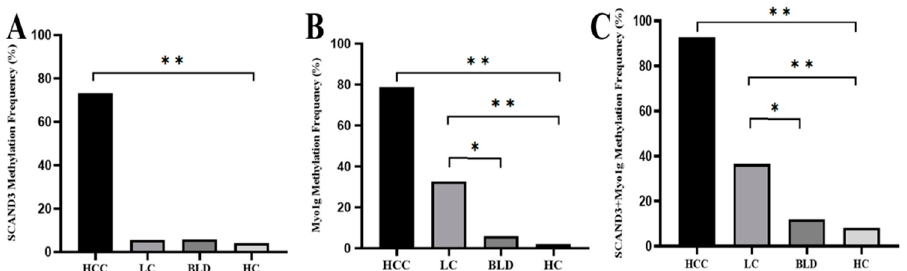
Figure 4. The methylation frequency of serum SCAND3, Myo1g, and SCAND3 + Myo1g in the HCC, HBV (hepatitis B virus)-related liver cirrhosis (LC), benign liver disease (BLD), and healthy controls (HC) groups. ( A ) The SCAND3 methylation ratio among HCC patients (73.33%) was significantly higher than that of LC patients (5.7%), BLD cases (6%), and HC (4.1%) ( χ 2 = 151.12, p < 0.0001). There were no significant differences between the SCAND3 methylation levels in LC patients, BLD cases, and HC ( χ 2 = 0.217, p = 0.897). ( B ) The Myo1g methylation ratio among the HCC patients (78.79%) was significantly higher than that of the LC patients (32.69%), BLD cases (6%), and HC (2%) ( χ 2 = 137.8, p < 0.001). The methylation levels in the LC patients were higher than that in the BLD cases ( χ 2 = 7.76, p < 0.05) and HC ( χ 2 = 16.18, p < 0.001). ( C ) The “SCAND3 + Myo1g” methylation ratio among the HCC patients (92.73%) was significantly higher than that of the LC patients (36.53%), BLD cases (12%), and HC (8%) respectively, ( χ 2 = 132.47, p < 0.001). The “SCAND3 + Myo1g” methylation levels in the LC patients were higher than those in the BLD cases ( χ 2 = 5.524, p < 0.05) and HC ( χ 2 = 11.55, p < 0.001). * p < 0.05, ** p < 0.01.